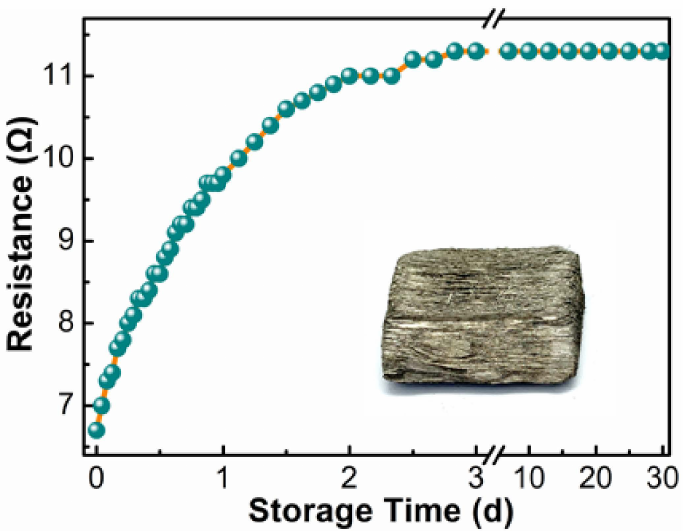
Figure 6. The resistance vs. storage time of the Ni-PW. The inset shows the Ni-PW stored for a